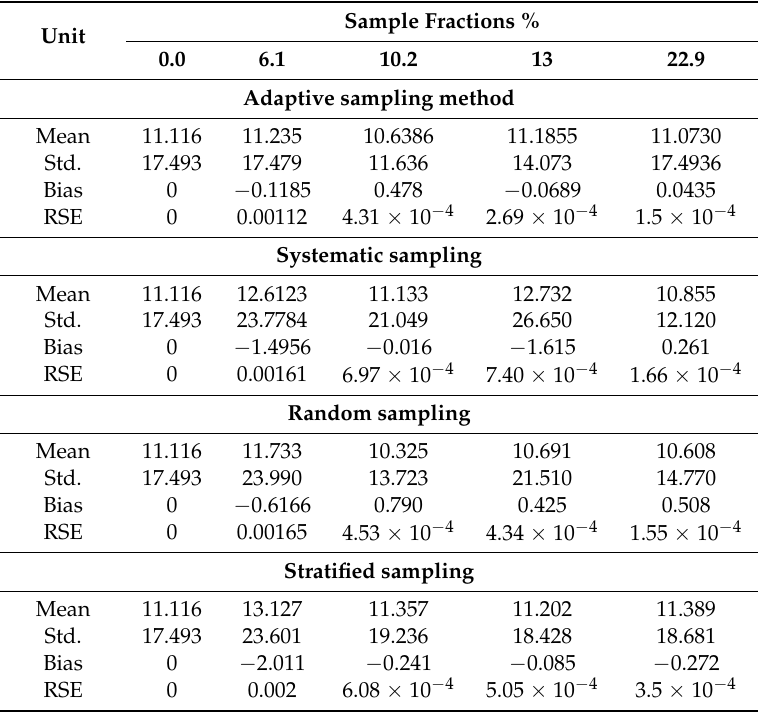
Table 5. Measurement results of jitter using different sampling methods: adaptive, systematic, random, and